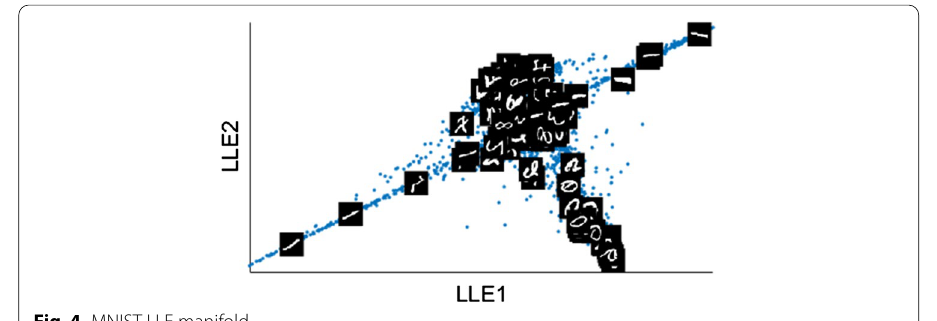
Fig. 4 MNIST LLE manifold